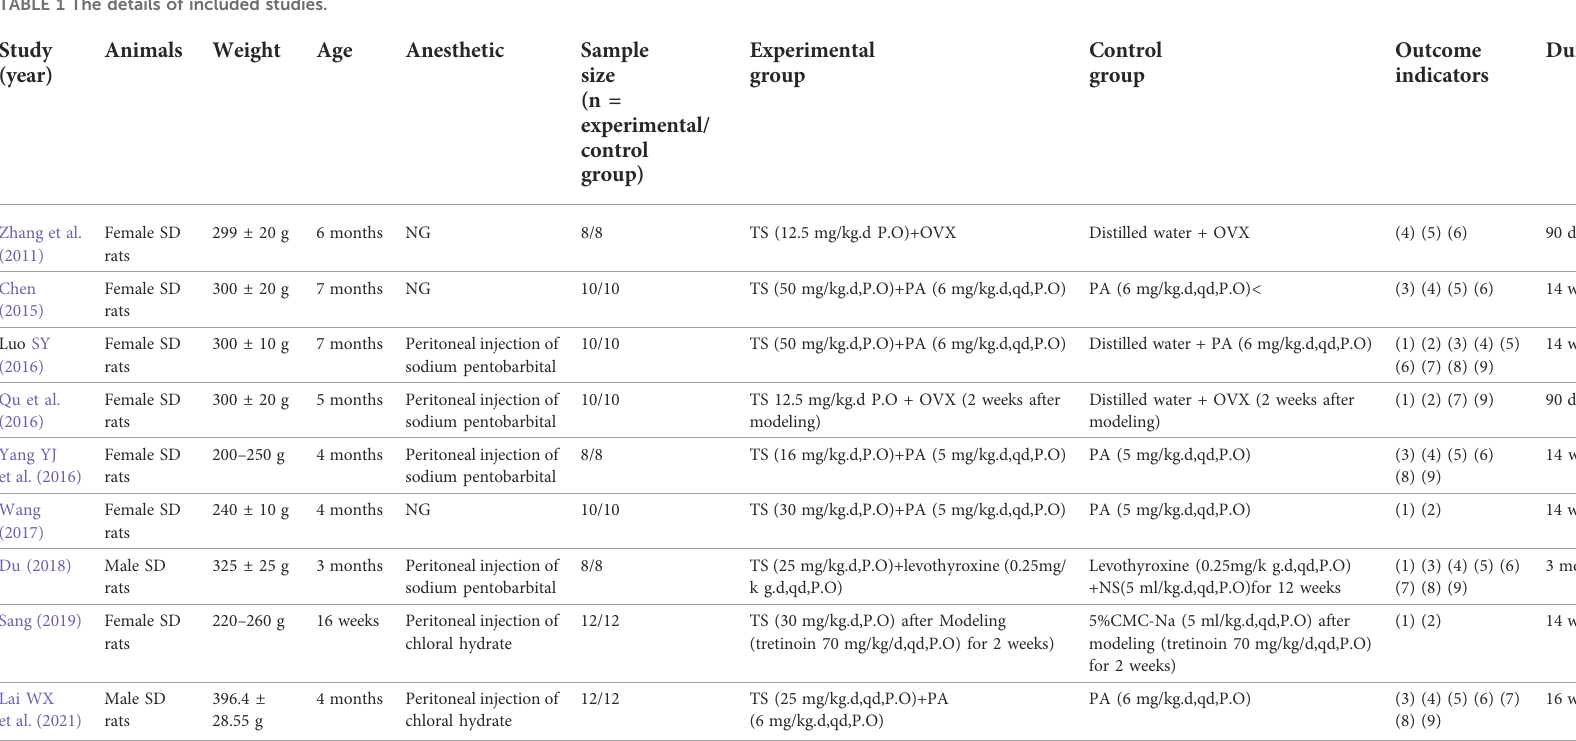
TABLE 1 The details of included